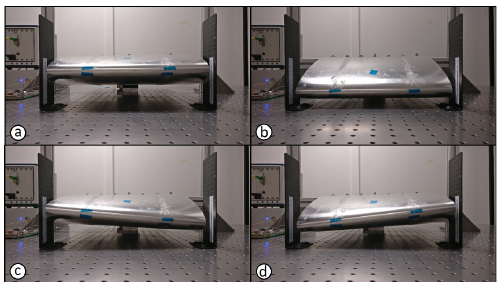
Figure 8. The position of the wing during ( a ) bend-up, ( b ) bend-down, ( c ) right-twist, and ( d ) left- twist morphing cases.